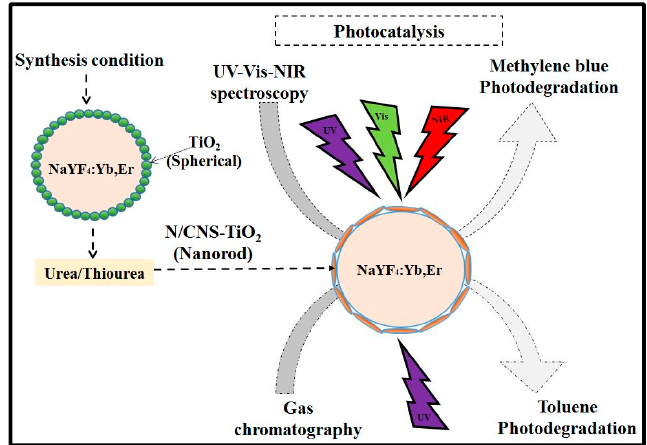
Figure 11. Schematic diagram for synthesis and photocatalysis tests.